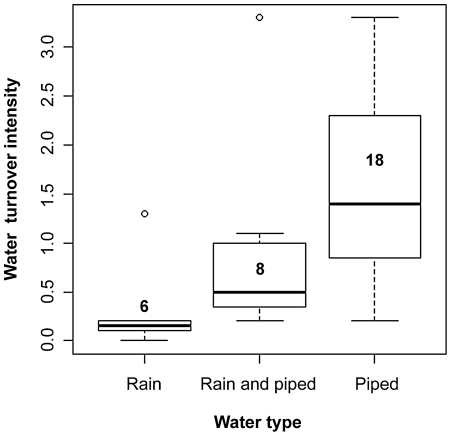
Box-and-whiskers plot of estimated water turnover according to water type.Water turnover was calculated as the estimated volume of water removed during the subsequent 48 hs post-addition of sodium chloride divided by the volume of each tank. The numbers indicate the number of tanks within each category. Main trial, Clorinda, 2009.